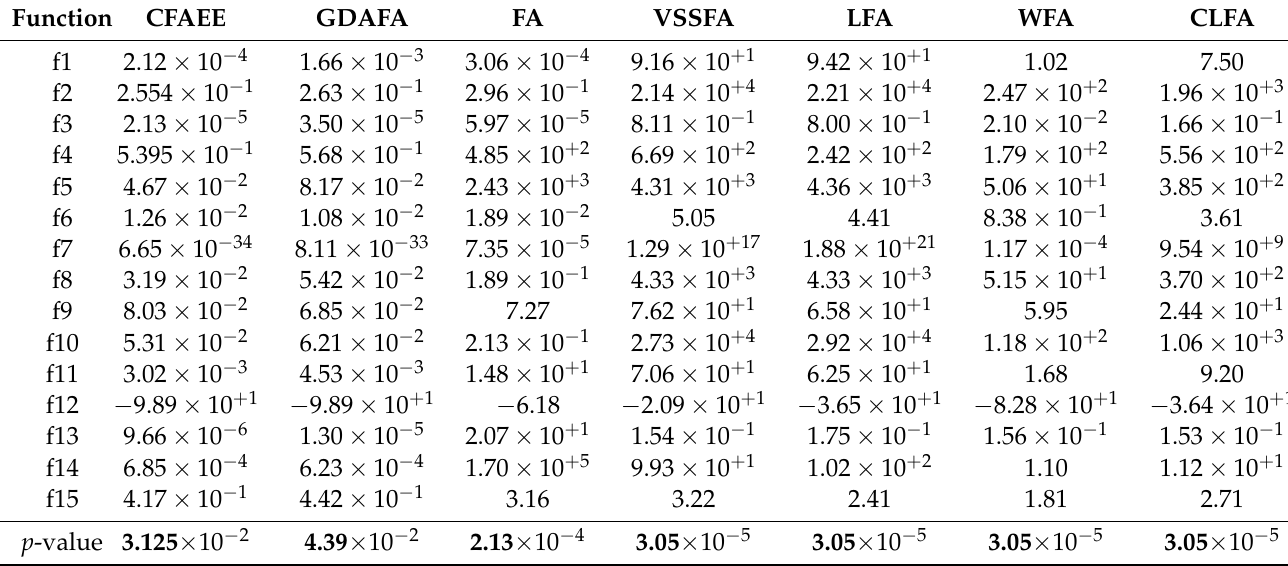
Table 8. Statistical comparison of results obtained by CFAEE for 100-dimensional benchmarks with other approaches by the Wilcoxon Signed-Rank Test at α =